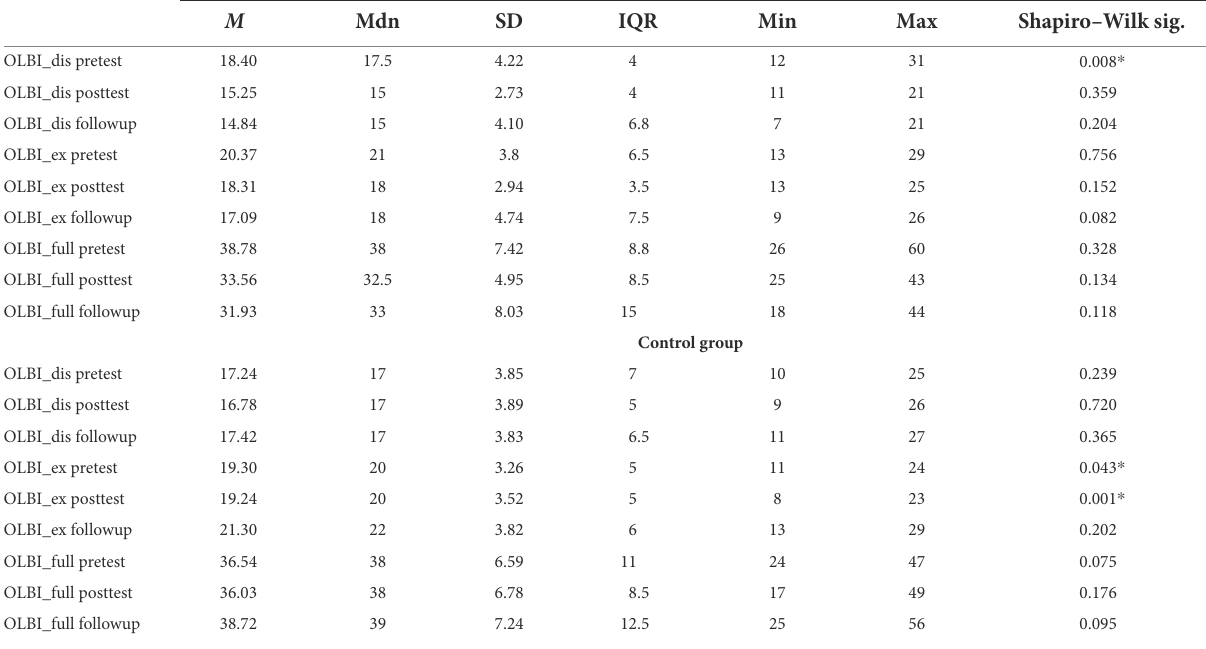
TABLE 2 Descriptive statistics for Burnout and